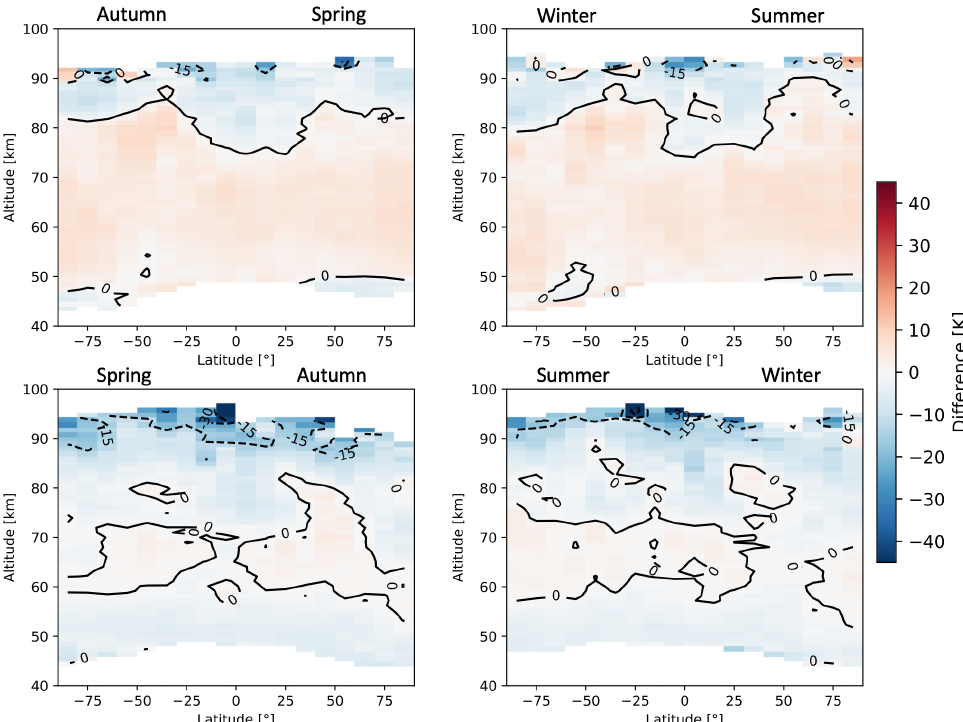
Figure A24. Seasonal zonal means of temperature FM13 SMR–MIPAS upper atmosphere absolute differences averaged over the time period indicated in Table 2. The seasons are intended as astronomical seasons, i.e. each starting at the respective solstice or equinox.